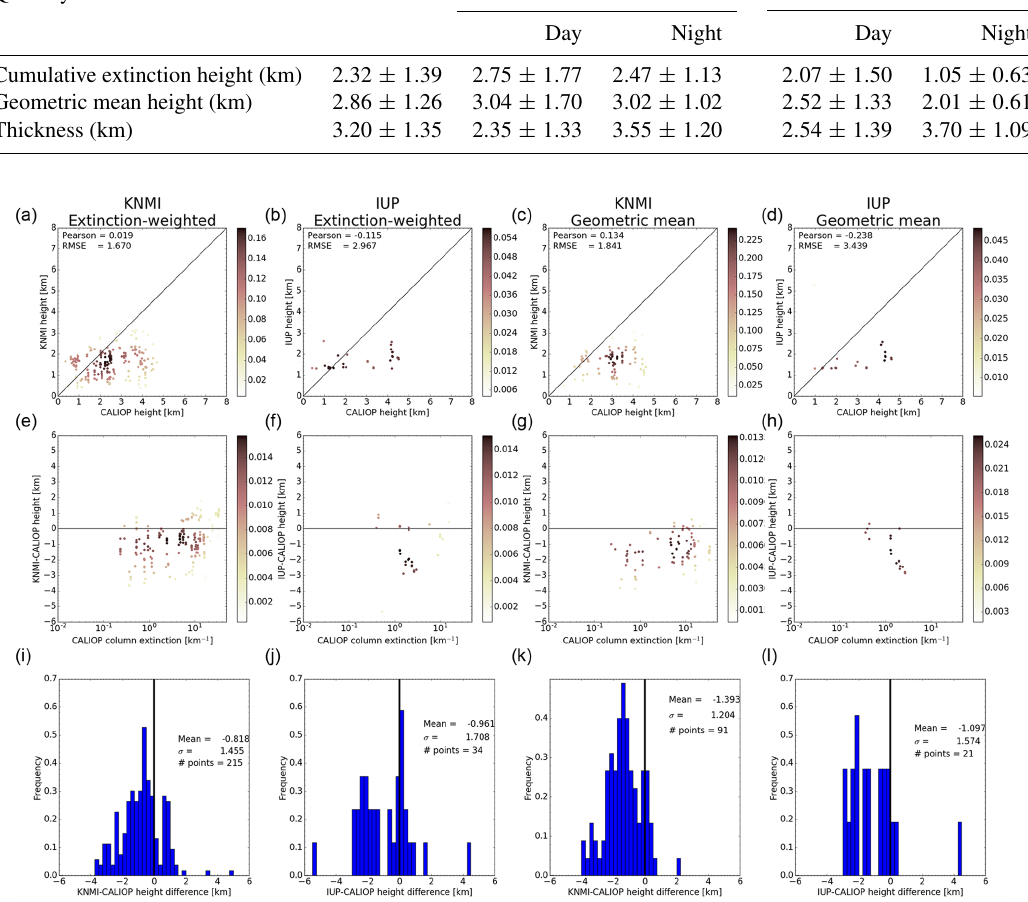
Figure 7. Similar to Figs. 5–6 but for the KNMI (a, e, i, c, g, k) and IUP (b, f, j, d, h, l) algorithms versus the CALIOP cumulative extinction (a, e, i, b, f, j,) and geometric mean (c, g, k, d, h, l) dust